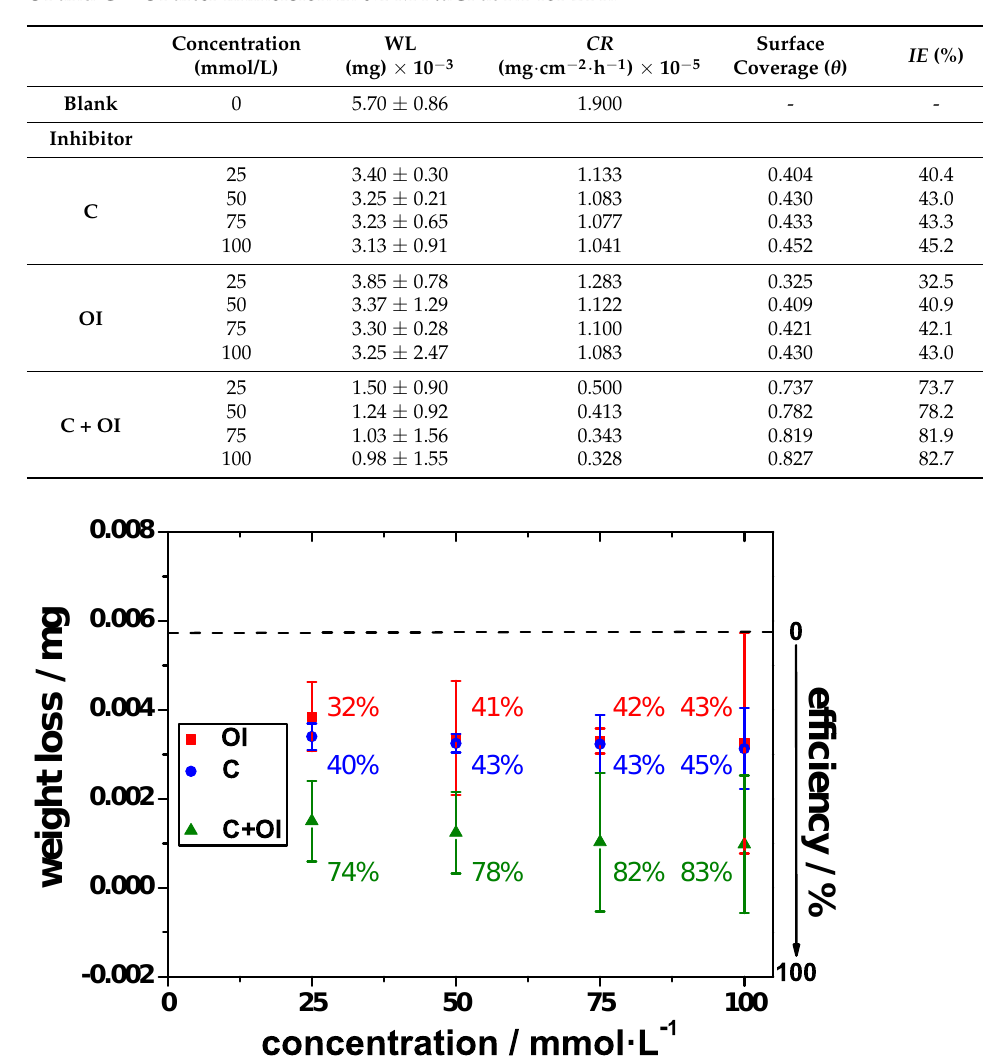
Figure 2. Results of WL measurements for compounds C (red squares) and OI (blue dots), and their combination C + OI (green triangles) recorded in 0.1 M NaCl for 24 h. The result of the untreated material is displayed as a black dashed line, for reference, and the efficiency is on the